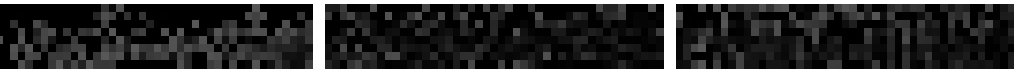
Figure 21. An example of three processed image formed in the second step.